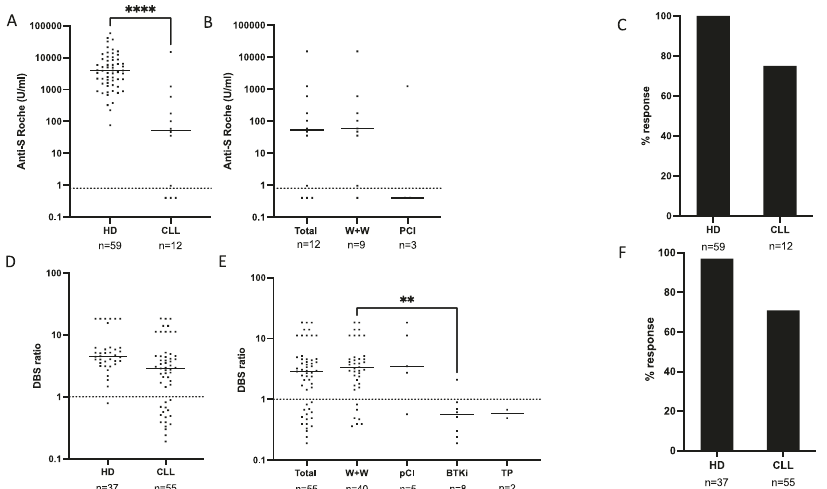
Fig. 3 Antibody responses in patients with CLL following second Covid-19 vaccine. A Antibody responses to SARS-CoV-2 Spike following second vaccine in sera from healthy donors (HD) and patients with CLL, as measured by Roche assay. No donors had evidence of previous exposure (cut off for positivity at 0.8 indicated by dotted line). B Dot plot of antibody responses to SARS-CoV-2 Spike in patient with CLL following second vaccine, by management stage is shown, (W + W watch and wait; PCi previous chemo-immunotherapy but not on active therapy) as measured by Roche. C Bar chart to show the percentage response after second vaccine in HD and CLL measured by Roche. D Antibody responses to SARS-CoV-2 spike following second vaccine in healthy donors (HD) and patients with CLL, as measured by TBS assay (cut off for positivity indicated by the dotted line at a ratio of 1). E Antibody responses to SARS-CoV-2 Spike in patient with CLL following second vaccine, by management stage, DBS testing and analysed by TBS assay (Kruskal – Wallis p < 0.0045 and Dunn ’ s analysis for BTKi therapy and W + W p = 0.03). Watch and Wait (W + W); Previous Chemo-immunotherapy but not on active therapy (pCI); Bruton Tyrosine Kinase therapy (BTKi); Treatment planned (TP). F Bar chart to show the percentage response after second vaccine in HD and CLL measured by TBS assay using DBS